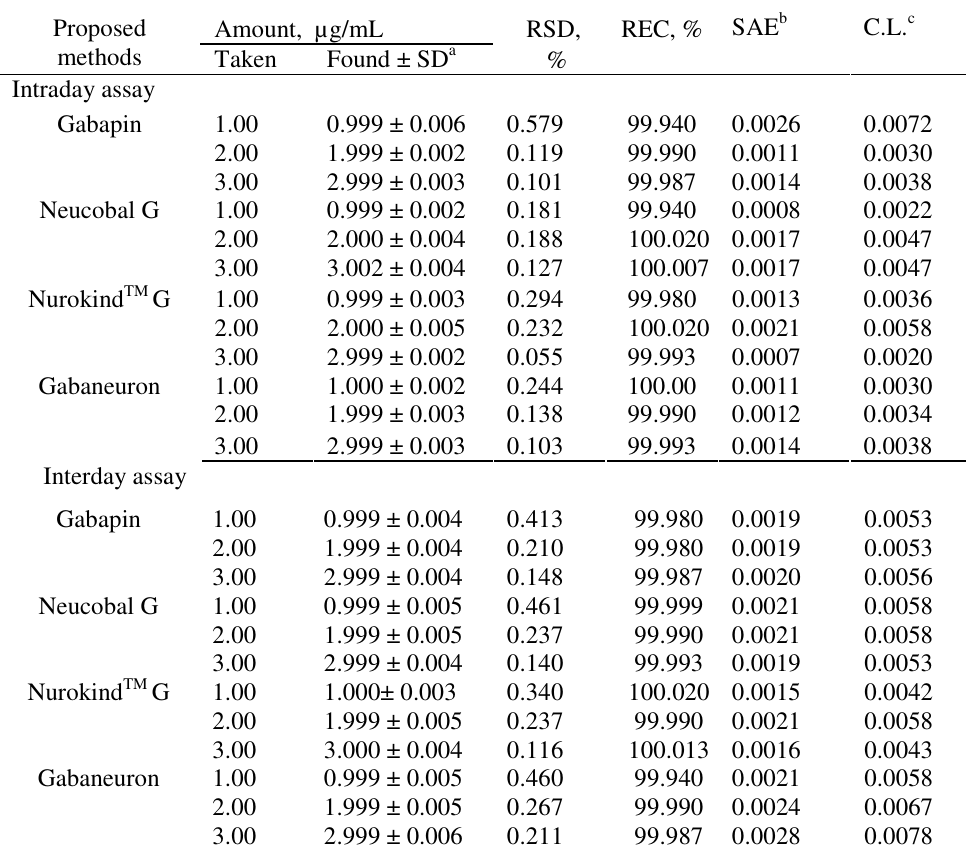
Table 3. Summary of accuracy and precision results of the proposed method in pharmaceutical